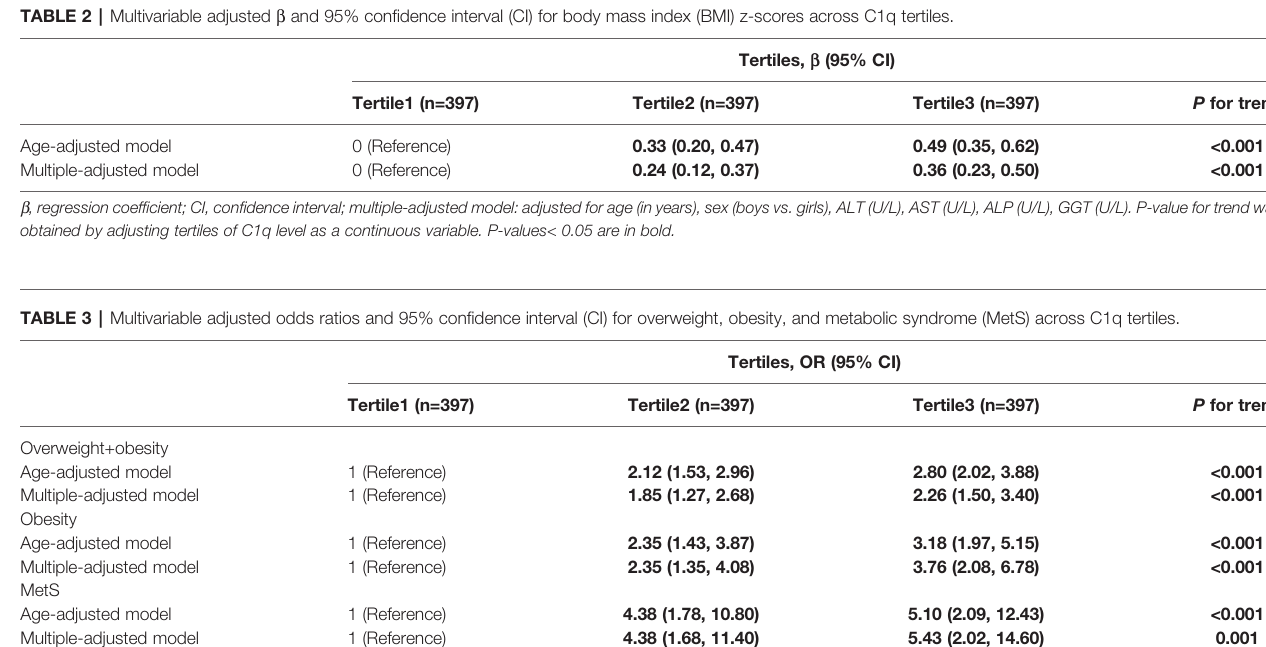
OR,oddsratio; CI,con fi denceinterval; Multiple-adjusted model:adjustedforage(inyears),sex(boysvs.girls), ALT(U/L), AST(U/L),ALP(U/L), GGT(U/L).P-value fortrend wasobtained by adjusting tertiles of C1q level as a continuous variable. P-values< 0.05 are in